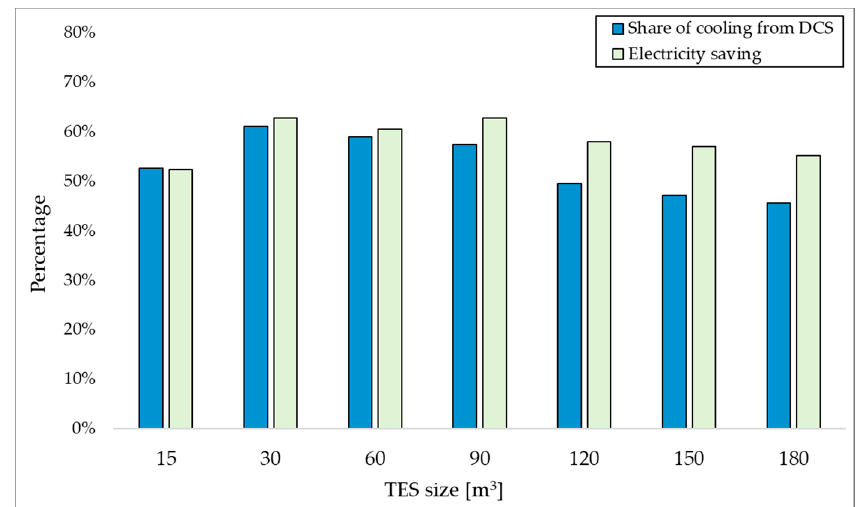
Figure 9. Percentage share of cooling from DCS to meet the total users’ demand and electricity saving for different thermal energy storage (TES) sizes.